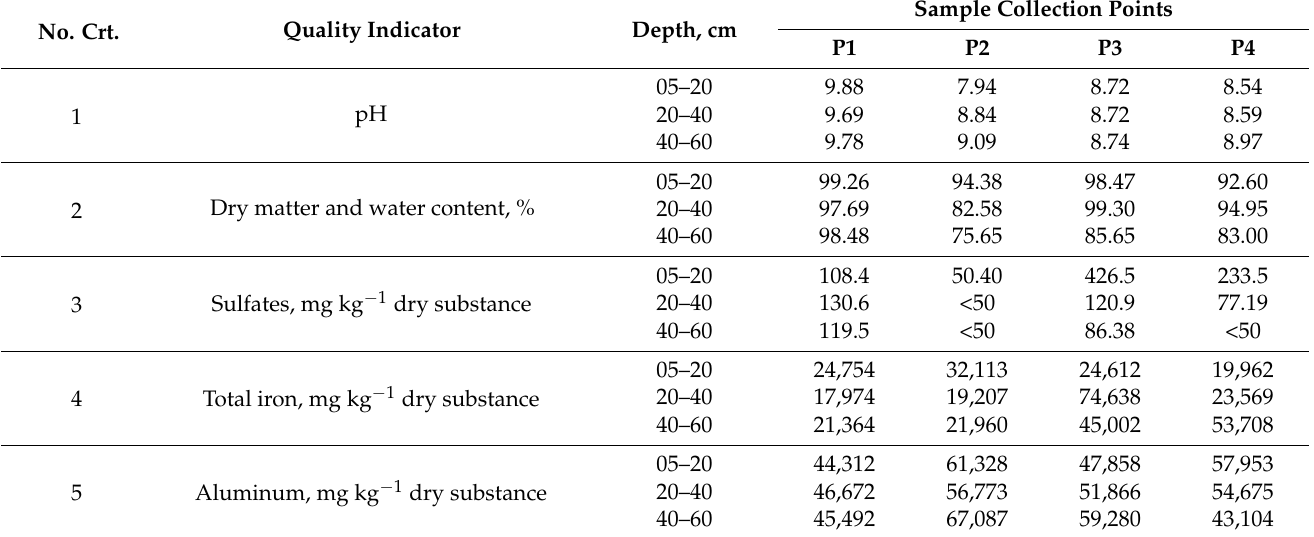
Table 3. Influence of C0 sludge dump on soil